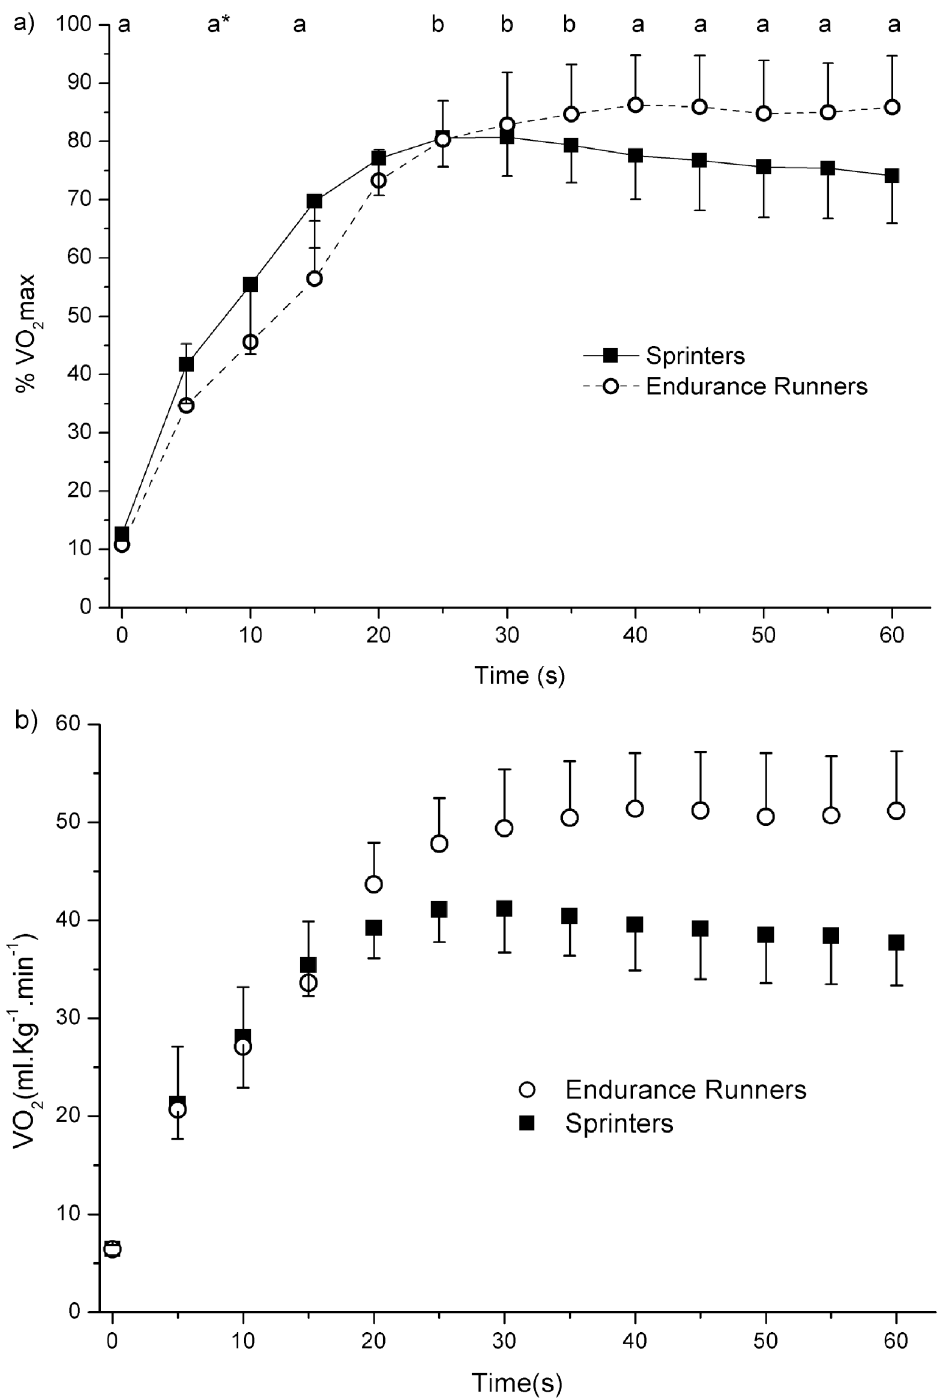
Fig 2. Time course of the V ̇ O 2 during the 1 min all-out running test in sprinters and endurance runners. VO 2 was expressed in relative (%VO 2 max) and absolute terms in Fig 1A and 1B, respectively. Statistical analysis was only performed on relative terms. a significant difference between groups ( p < 0.05); p = 0.09); b V ̇ O V ̇ O a * statistical trend for a higher V ̇ O 2 in sprinters ( 2 significantly higher than end-exercise 2 in sprinters ( p <